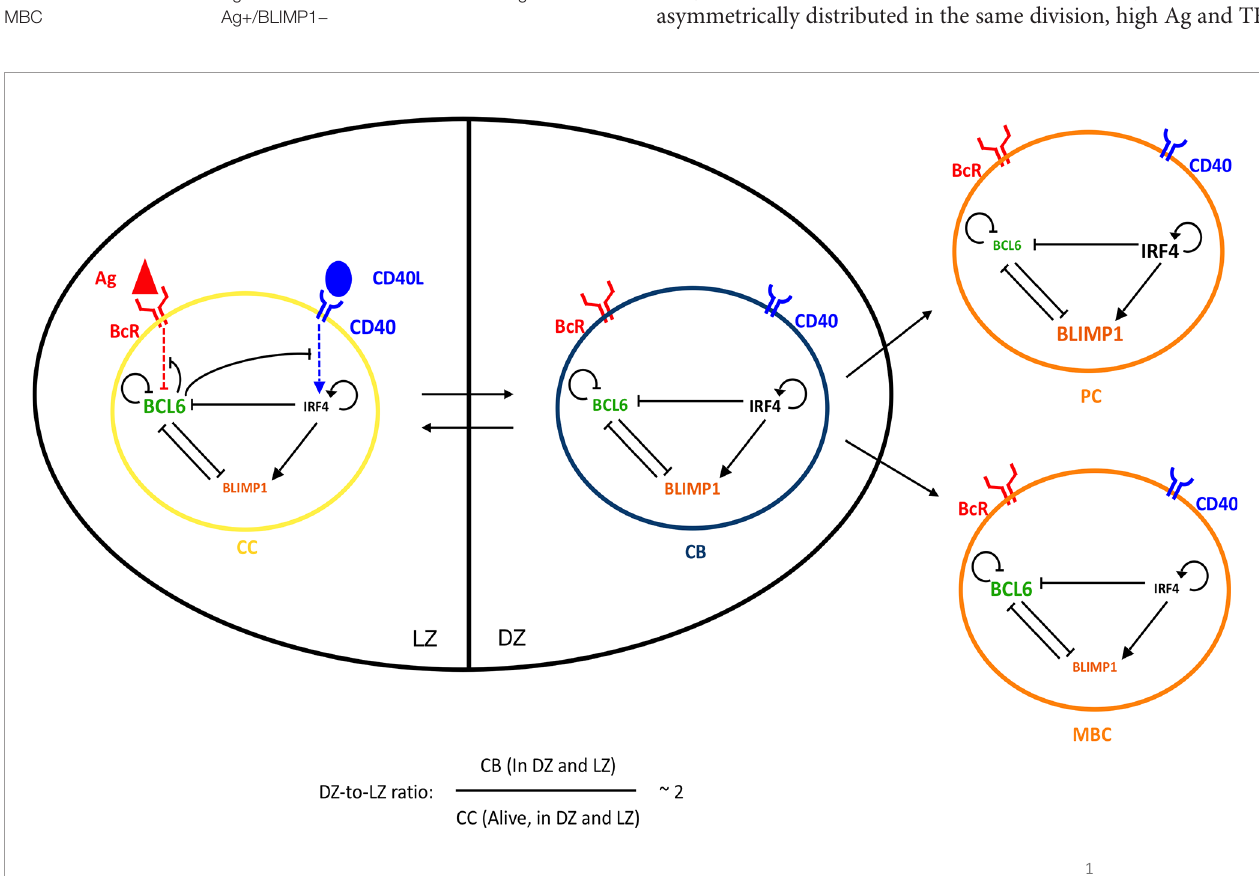
FIGURE 1 | Four GC B cells representing the PC differentiation process: CC (yellow), CB (blue), PC (orange), and MBC (orange). CBs are mainly present in the DZ and CCs in the LZ, while PCs and MBCs are mainly generated in the DZ and then exit the GC. Transition between CBs and CCs is reversible, while the transition between CBs and PCs or MBCs is irreversible. The DZ-to-LZ ratio is the ratio of CBs to non-apoptotic CCs present in both zones and fl uctuates around 2. An intracellular GRN comprising three TFs is embedded in each B cell: BCL6 (green), IRF4 (black), and BLIMP1 (orange). The size of each TF represents the expression levels in the cell state. The CC BcR may bind to Ag (red) or the CD40L (blue) when receiving T-cell help, resulting in BcR and CD40 signaling, respectively, which changes the state of the network. Arrows between cells represent transition. Arrows between TFs, BcR, and/or CD40 indicate activation. Bar-headed lines denote